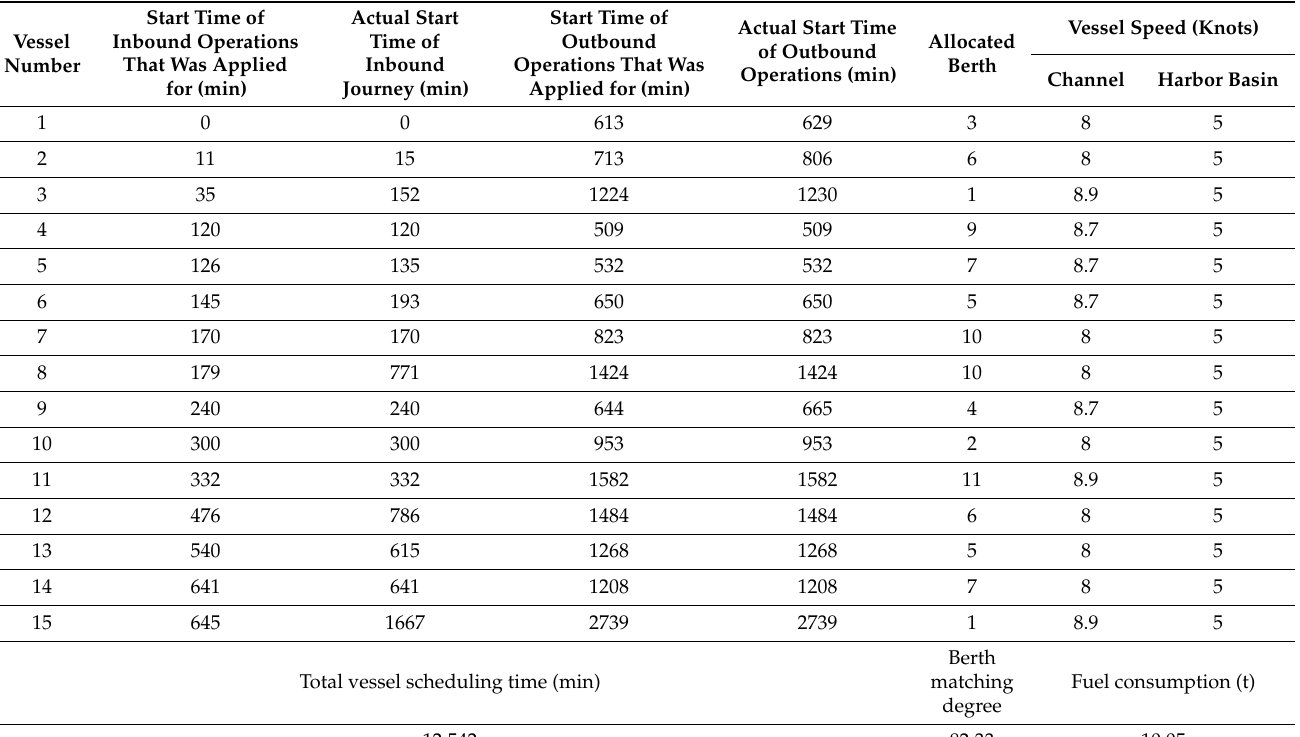
Table 7. Optimal solutions with the optimal total scheduling time in the Pareto solution set.